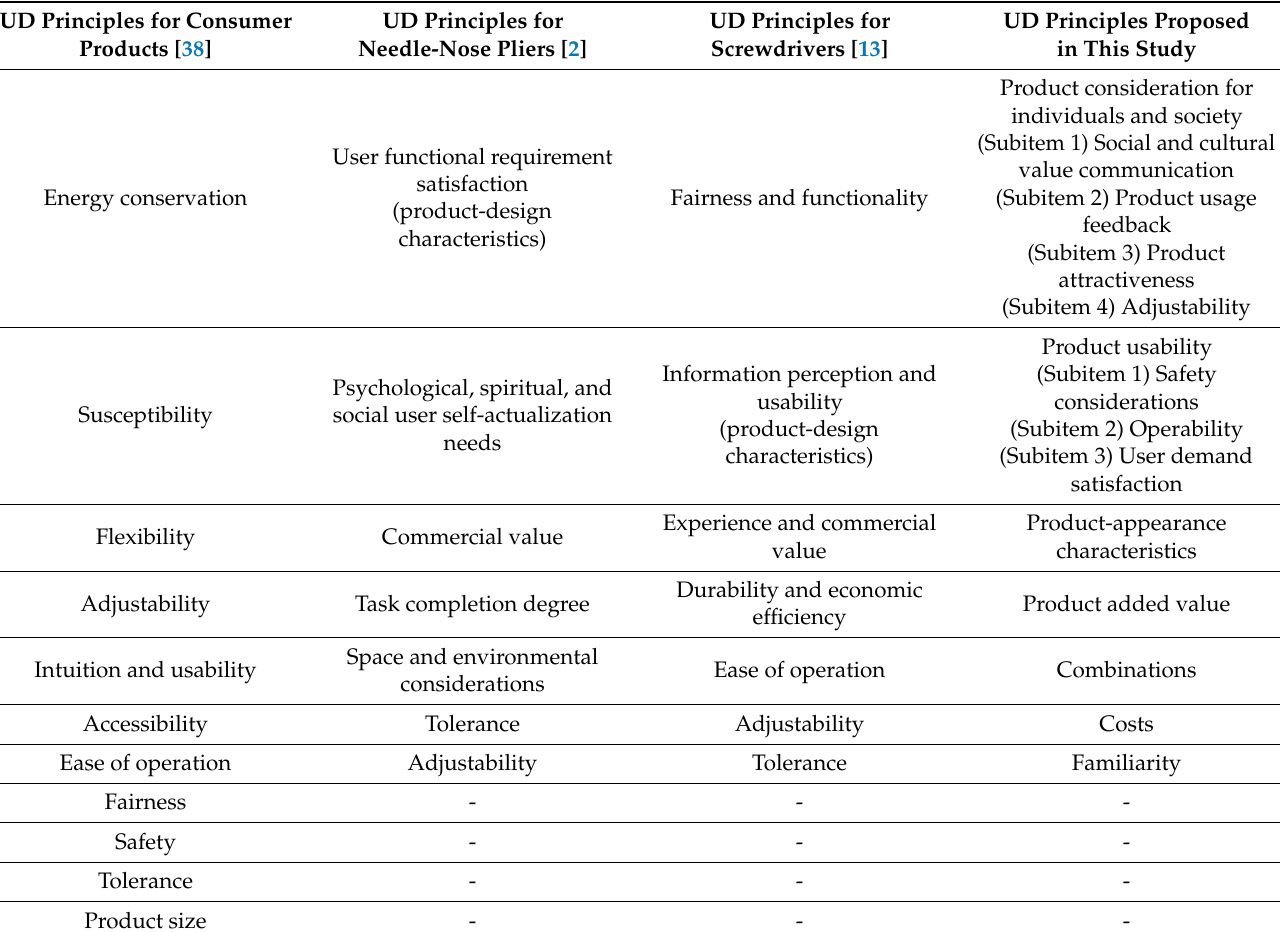
Table 3. Comparison and difference with UD